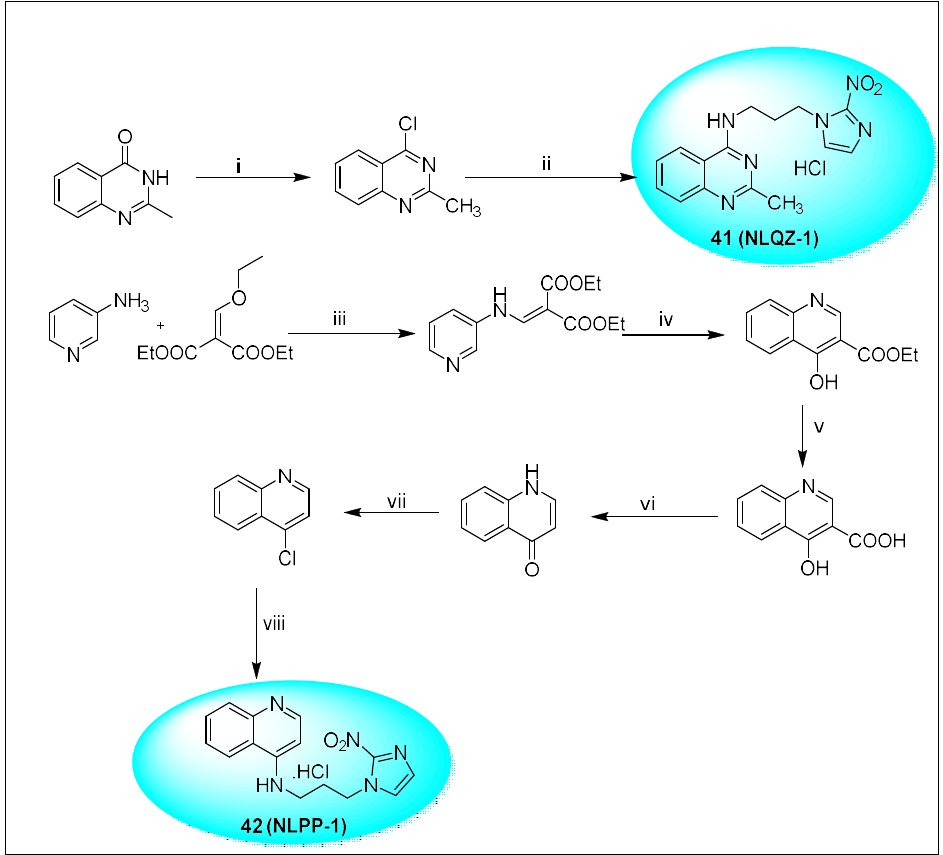
Table 3. Various parameters of the hypoxia-selective cytotoxins 41 (NLQZ-1) and 42 (NLPP-1) and comparison with NLCQ-1 in V79